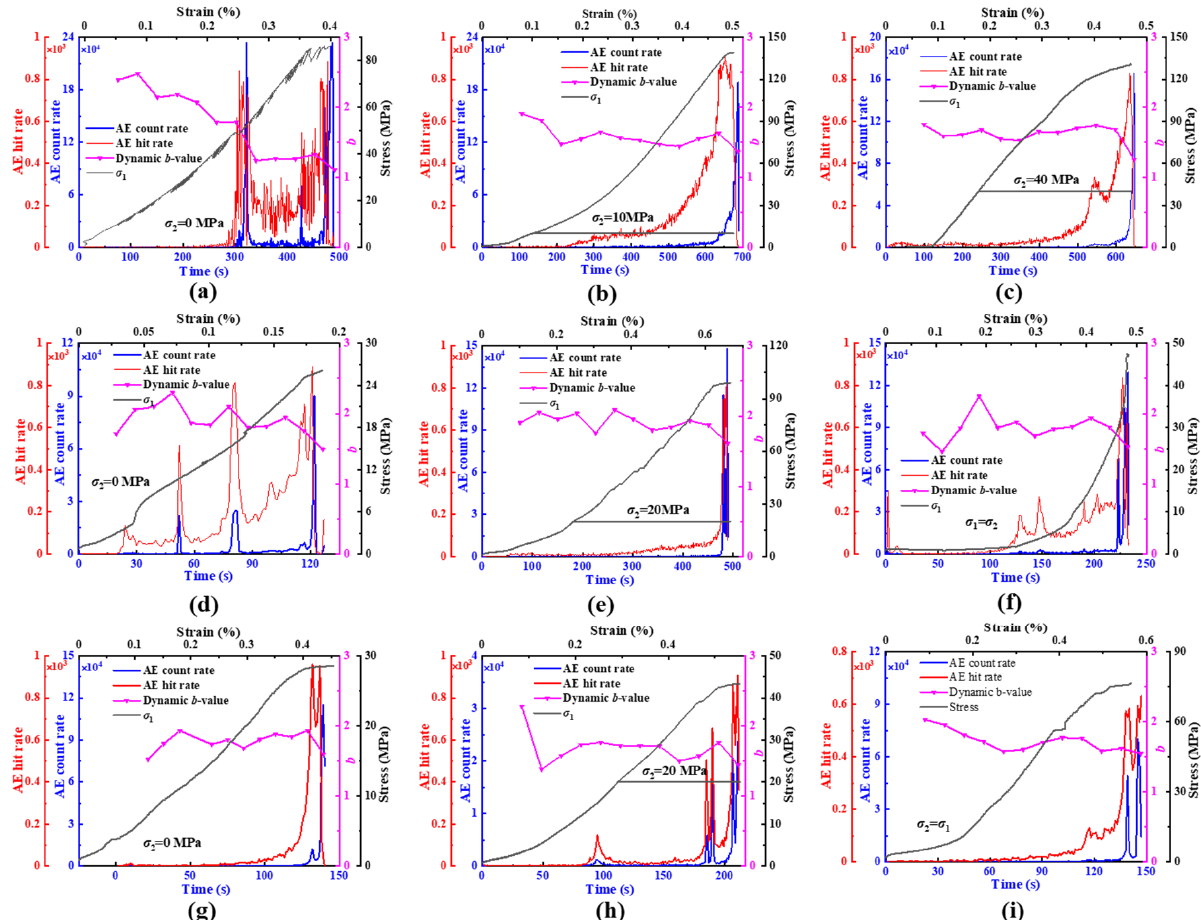
Figure 9. Changes of AE hit rate, AE count rate, and b-value with time and the corresponding stress–strain curves: ( a – c ) granite; ( d – f ) marble; ( g – i ) sandstone.